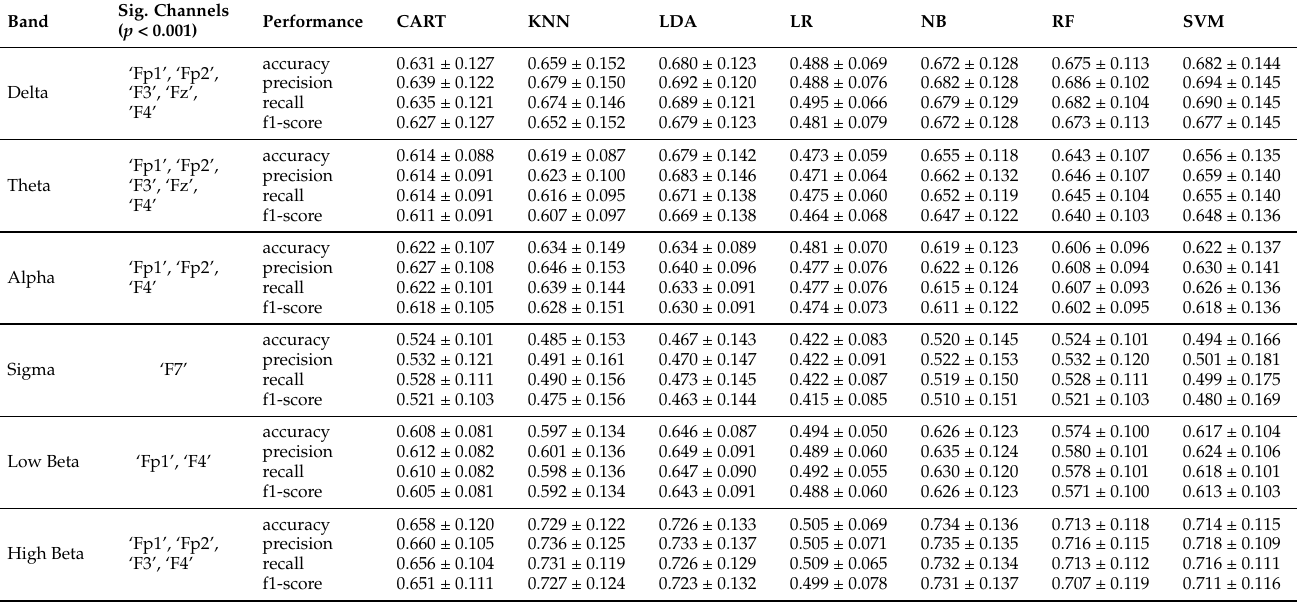
Table 4. The summary of average accuracies and standard deviations of significant frequency-domain features from the selected channels with the seven classifiers.